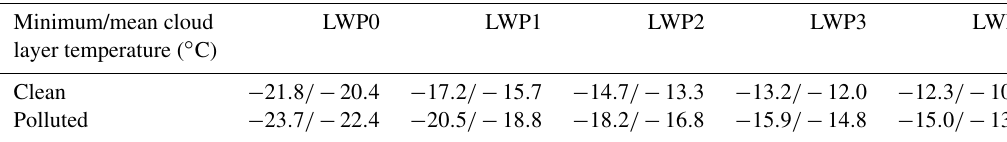
Figure 4. (a) Reflectivity and (b) mean Doppler velocity from the MMCR for a LWP0 cloud on 19 January 2006. Time from hours 15 to 16, marked between the red vertical lines, is the sample period used in this analysis. Table 2. In-cloud minimum temperature and mean cloud layer temperature for profiles in each LWP